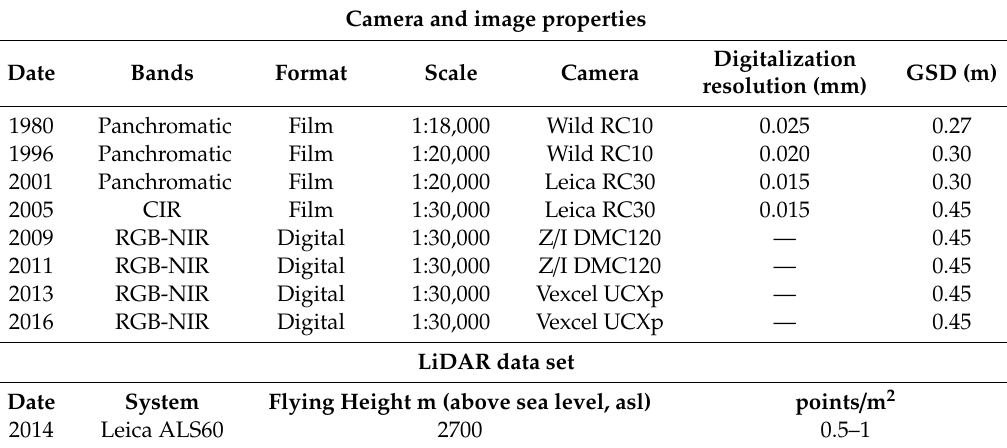
Table 1. Properties of the images and LiDAR data